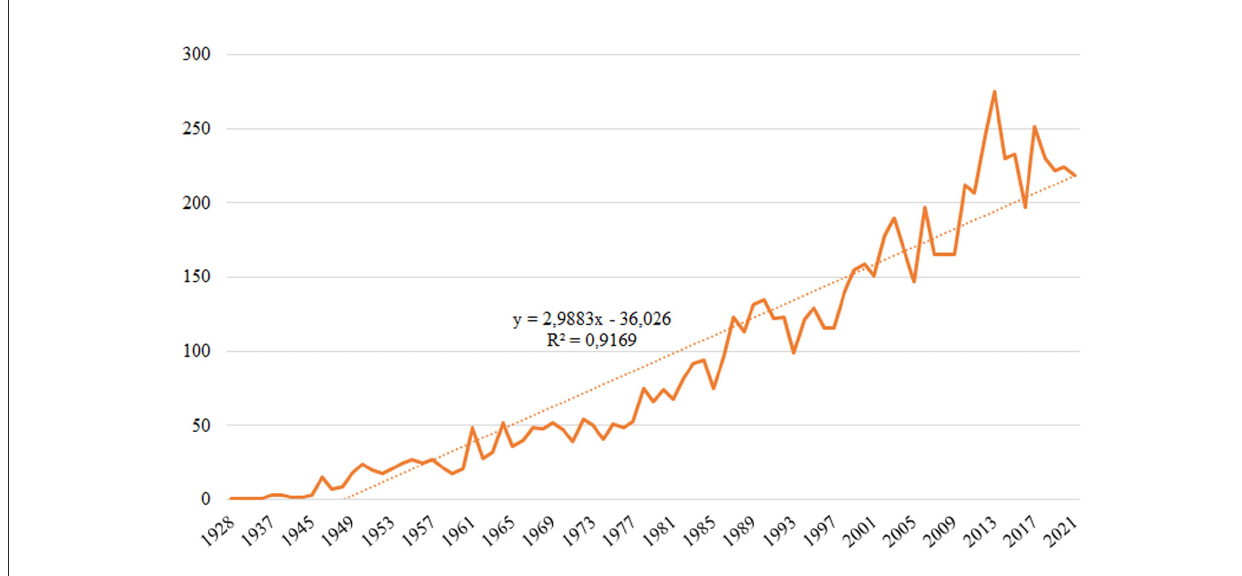
FIGURE1 Evolution of the annual number of documents published on cysticercosis and neurocysticercosis and included in the MEDLINE database.